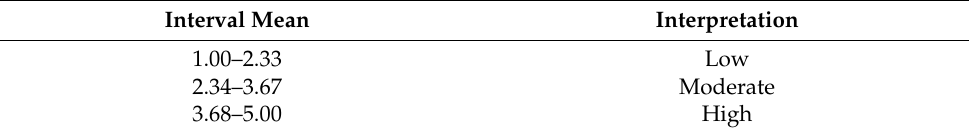
Table 2. Analysing criteria.